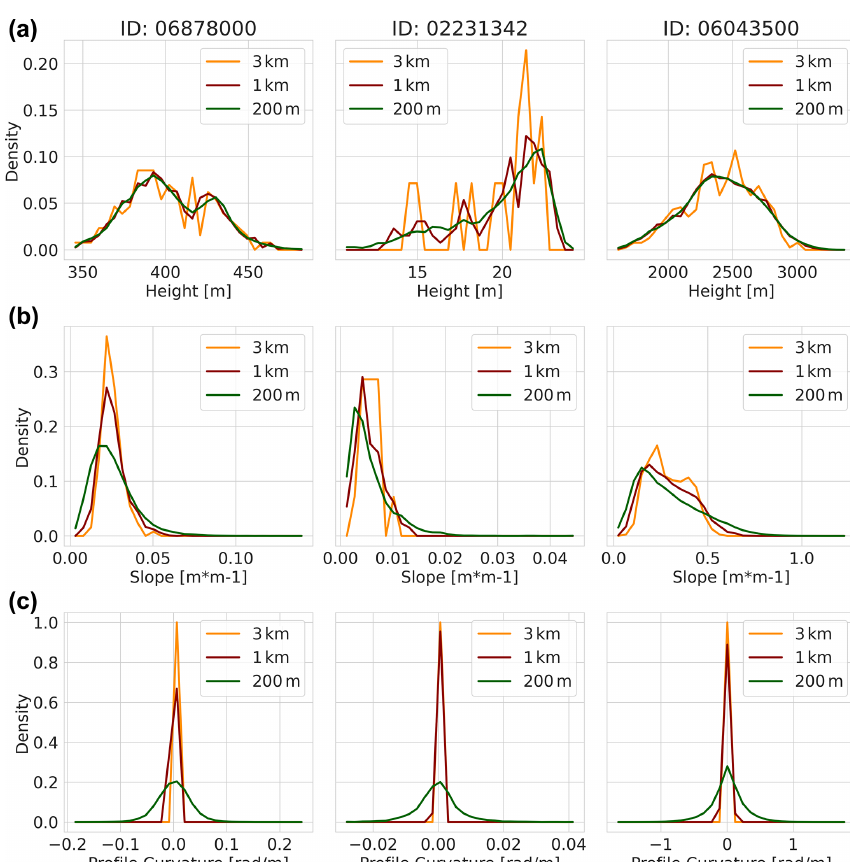
Figure 11. Three example basins that represent poor streamflow performance (ID:06878000), moderate performance (ID:02231342), and good performance (ID:06043500). (a) The PDF of height distribution for the 3km (orange), 1km (red) and 200m (green) model instances. (b) The PDF of the slope distributions of the model instances per basin. (c) The PDF of profile curvature distributions of the model instances per basin. Values that equal 0 indicate linear-slope geometry, smaller than 0 concave-slope geometry, and larger than 0 convex-slope